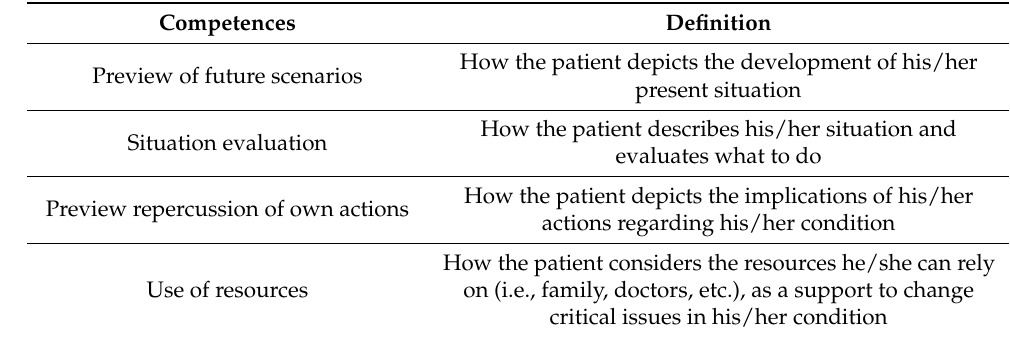
Table 1. Description of the four investigated competences.